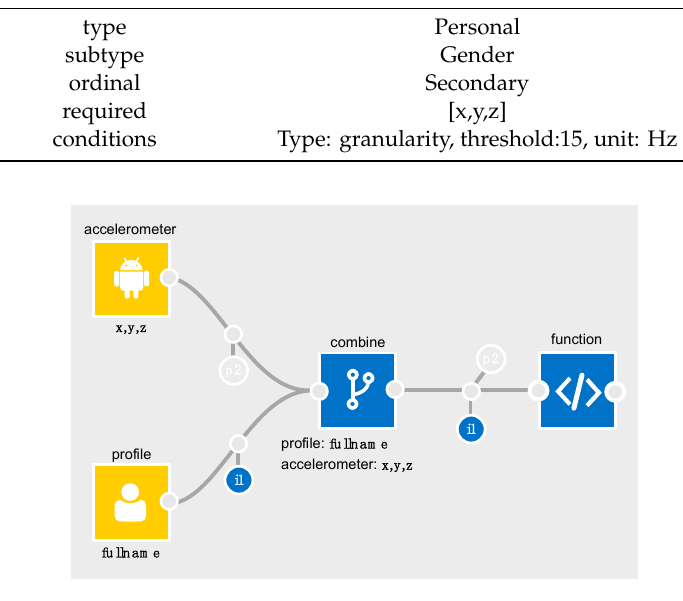
Figure 3. Applying the schema (a).